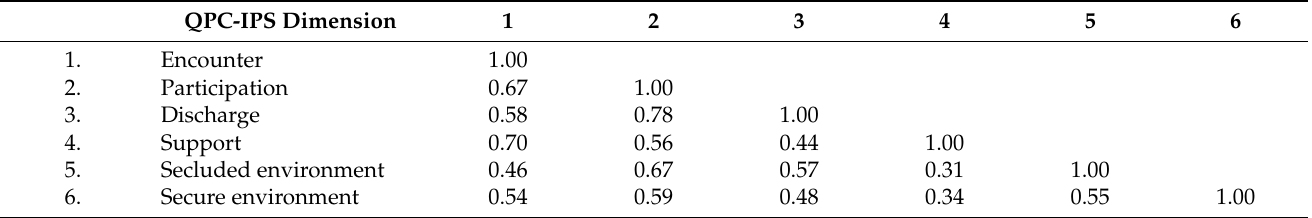
Table 3. Correlation coefficients for the QPC-IPS dimensions among staff in inpatient psychiatric care.